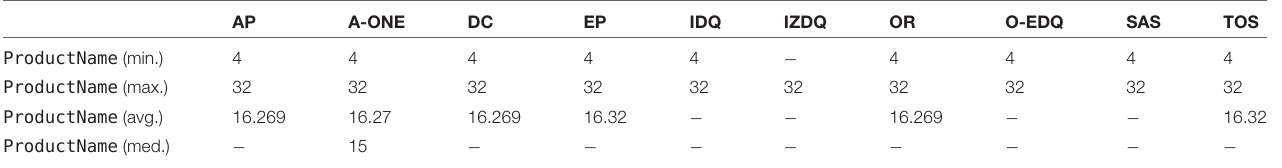
TABLE 8 | Data profiling—test case value length. AP A-ONE DC EP IDQ IZDQ OR O-EDQ